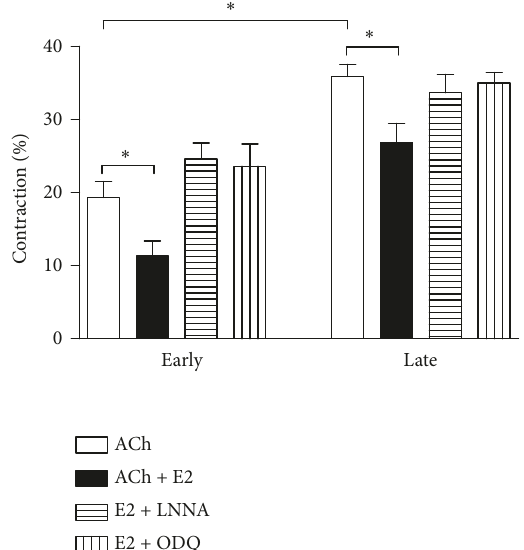
Figure 4: Changes in contraction of GSMC from early- and late- pregnant rats. Contraction of GSMC in response to ACh was significantly greater in cells from late-pregnant animals compared to cells from early-pregnant animals. Estrogen (E2) significantly inhibited ACh-induced contraction in GSMC of both groups of cells. Importantly, estrogen inhibition of contraction was greater in cells from the early-pregnant animals ( ∼ 41% reduction) compared to cells from the late-pregnant animals ( ∼ 25% reduction). L-NNA (NO synthase inhibitor) and ODQ (guanylyl cyclase inhibitor) significantly blocked estrogen effect in both groups. ( ∗ P < 0.05 for the groups in comparison, n = 30 cells from 10 different